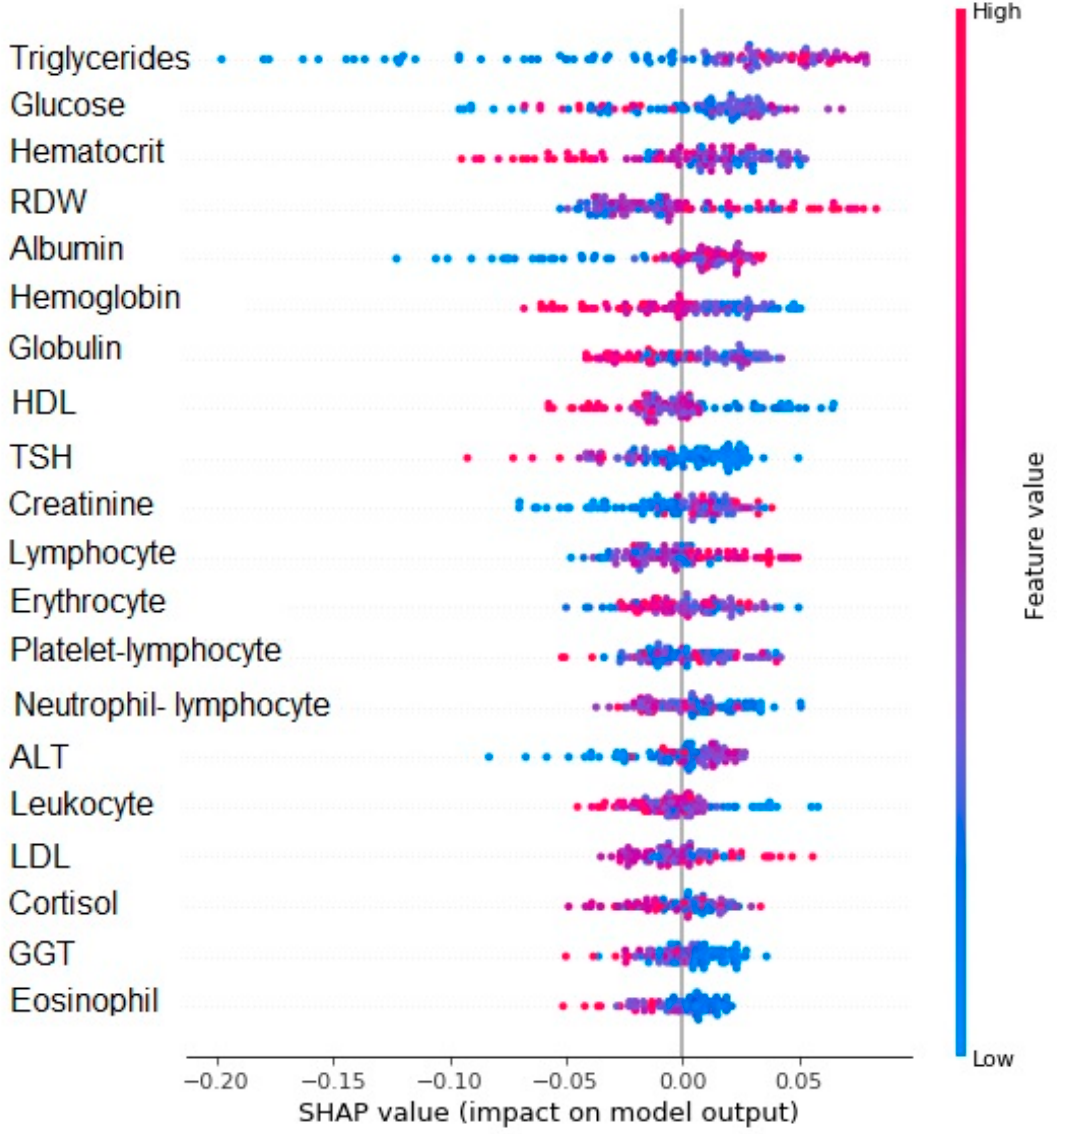
Figure 3. SHAP value for the random forest model regarding cognitive decline. Values below 0 on the X axis tend to not decline and values above 0 tend to show cognitive decline. The red color indicates the greater value of the variable, and the blue color indicates the lower value.